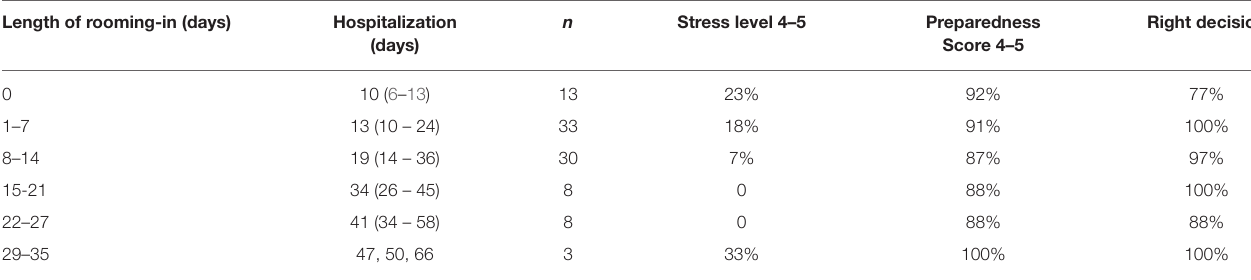
TABLE 2 | Association of length of rooming-in with stress level, preparedness, and right decision. Length of rooming-in